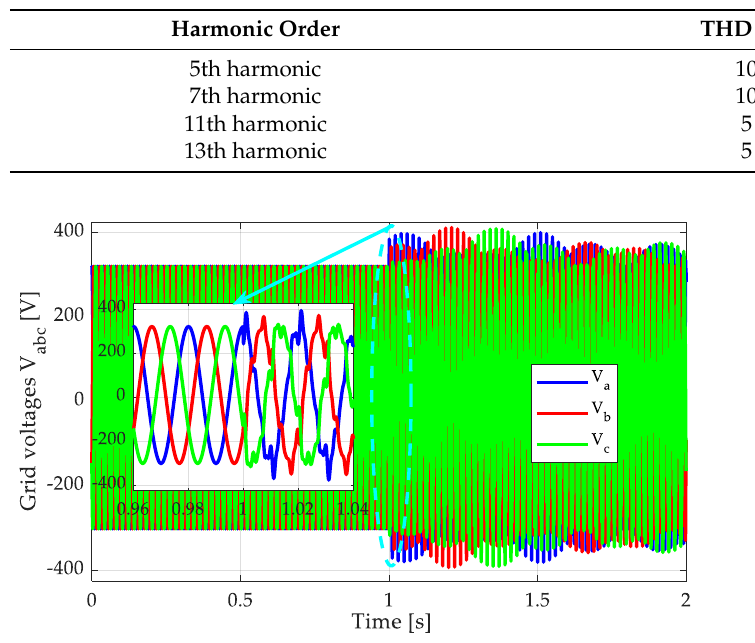
Figure 15. Grid voltages: scenario 2.